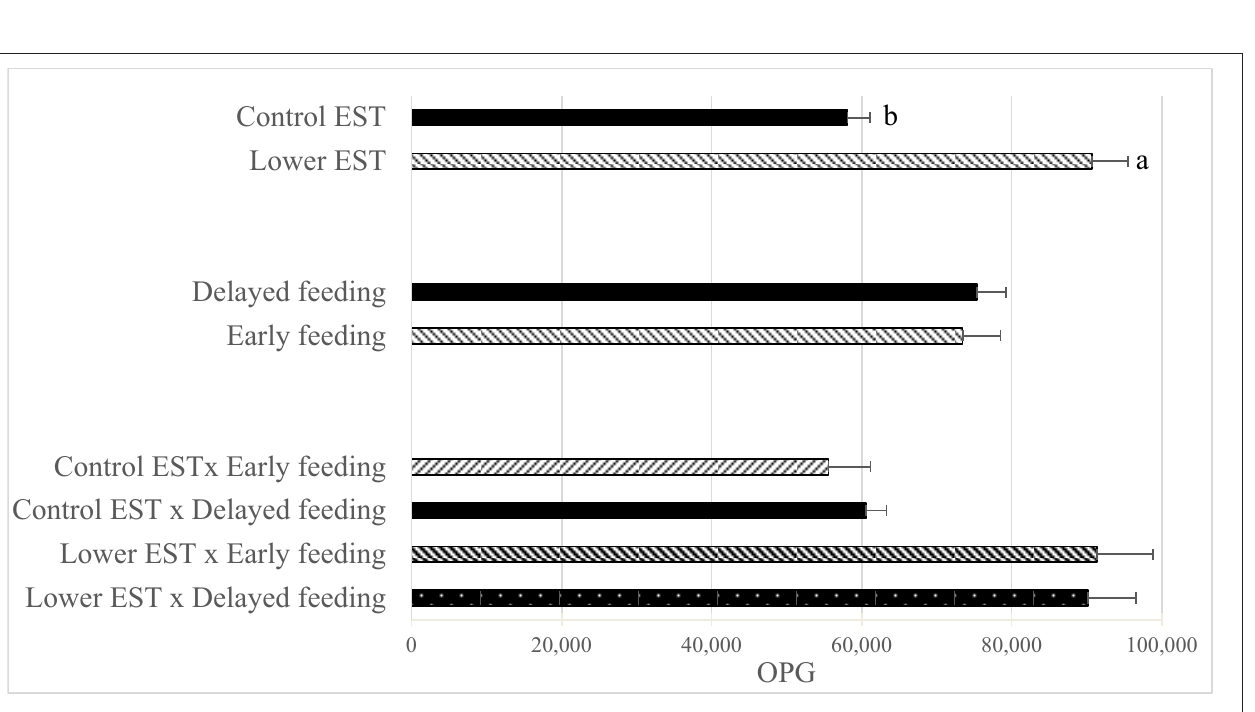
FIGURE 3 | Effect of eggshell temperature ( EST ) during late incubation [ ≥ embryonic day 17–19.5; 37.8 ◦ C ( control ) or 36.7 ◦ C ( lower )] and/or feeding strategy after hatch [immediate access to feed and water ( early ) or 51–54-h deprivation ( delayed )] on E. Maxima oocytes per gram feces ( OPG ) at d 8 post Eimeria inoculation (d 21 post hatch) to induce necrotic enteritis ( N = 16 pens/treatment). (a,b) Least squares means within a factor lacking a common superscript differ ( P < 0.05). Error bars indicate standard